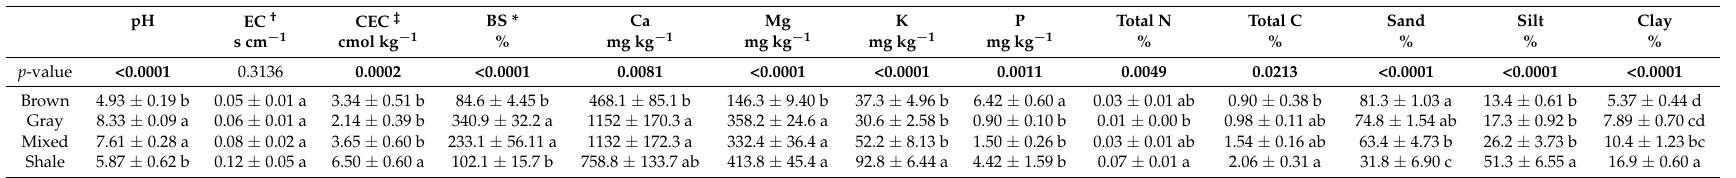
Table 1. Mean soil data ( ± SE) from four spoil types, 10 years after reclamation. Means with different letters are significantly different ( p < 0.05) from one another across spoil